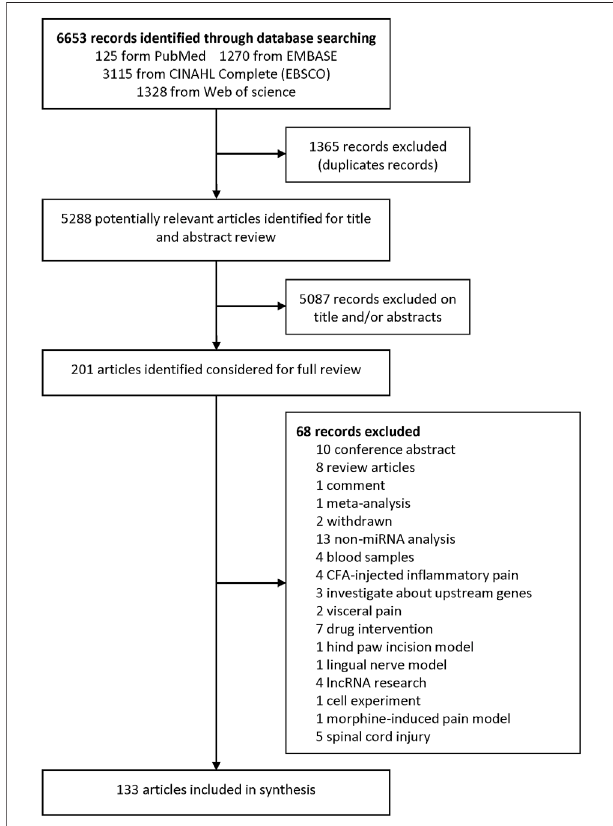
FIGURE 1 | Flow chart of the study selection